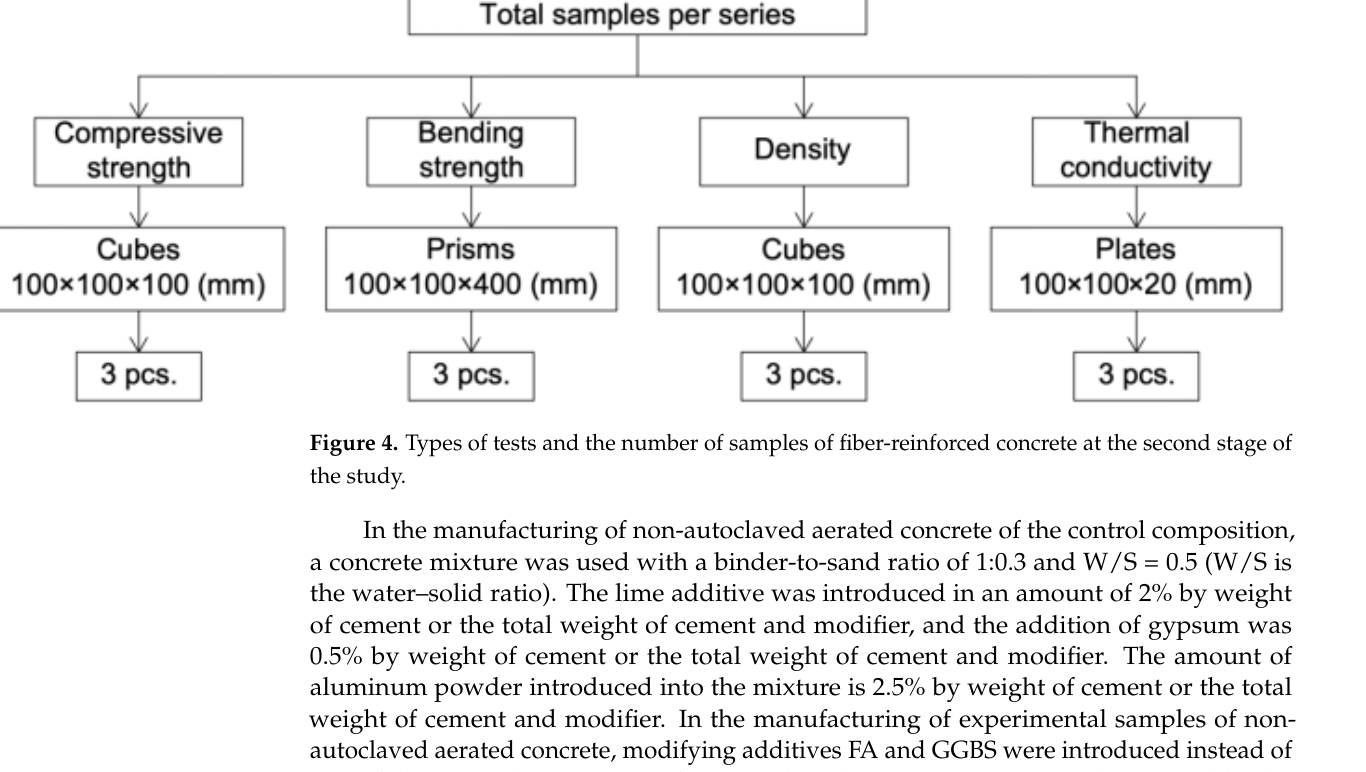
Figure 3. Plan of experimental studies of the second stage: determination of rational dosages of fiber. The types of tests and the number of fiber concrete samples at the second stage of the study are presented in the block diagram (Figure 4).